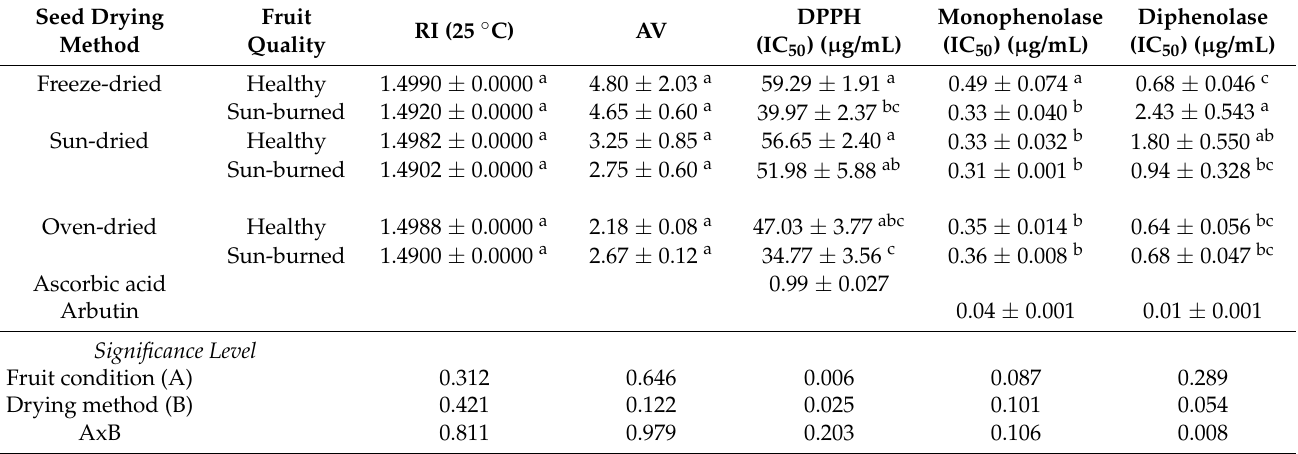
Table 1. Refractive index (RI), anisidine value (AV), DPPH radical scavenging ability, and tyrosi- nase enzyme inhibition of oil from seeds of healthy and sun burned fruit and dried under different drying methods.